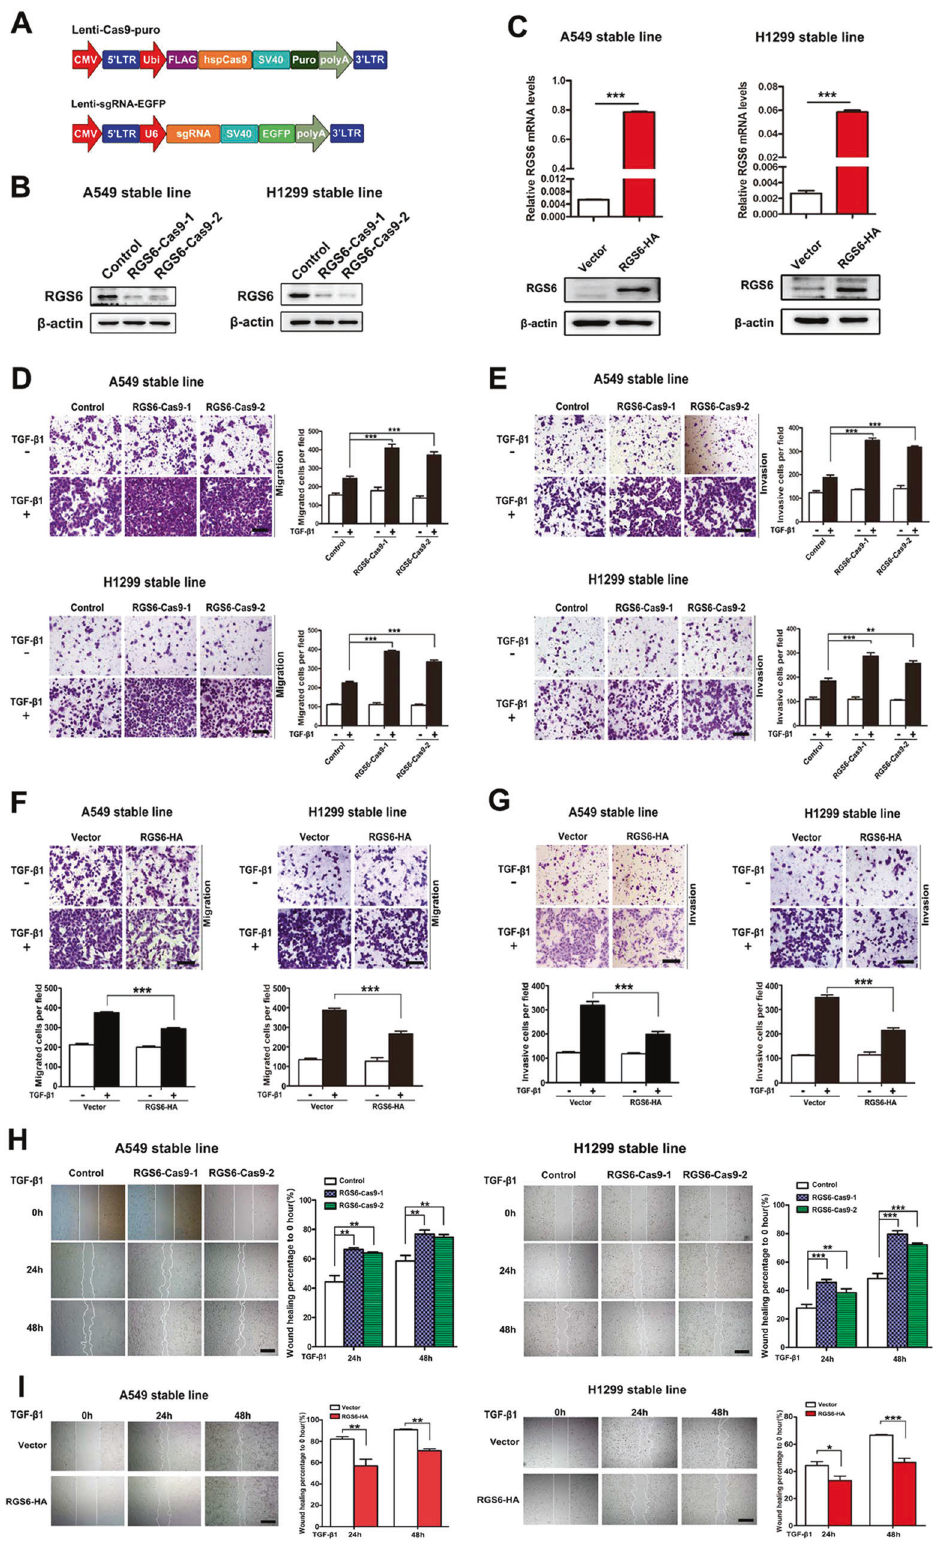
adjacent noncancerous tissues (Supplementary Table S1). Con- sistent with the result of TCGA analysis (Fig. 1A), a pattern of downregulation of RGS6 expression was indicated by the lower overall mRNA levels of RGS6 in tumor tissues compared with